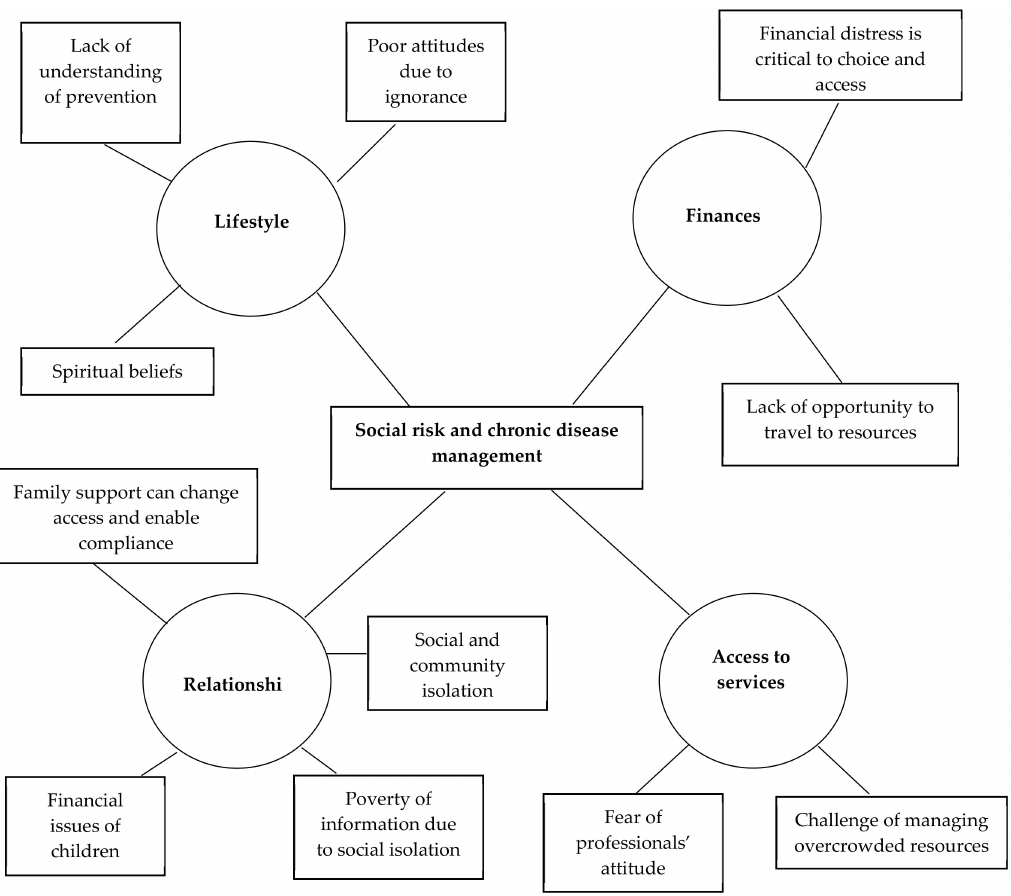
Figure 4. Thematic network: Social Risk